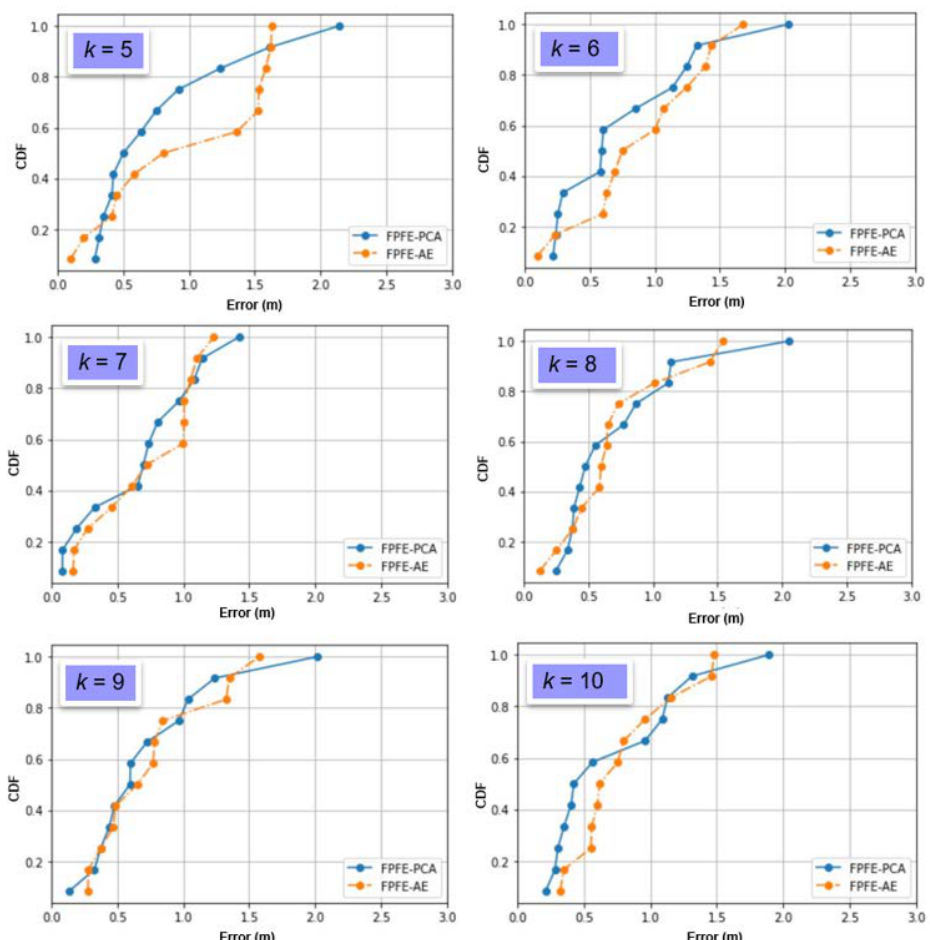
Figure 16. The localization error CDF curves of FPFE with 187 grid RPs for k RP candidates, where k = 5, 6, 7, 8, 9, and 10.